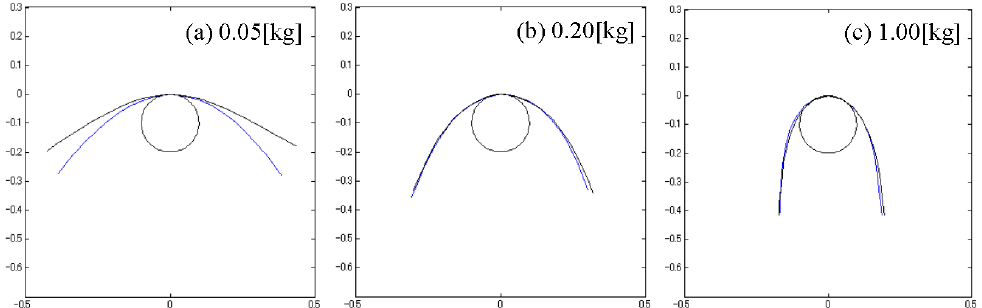
Figure 4. Experimental results when weights were added to each end.